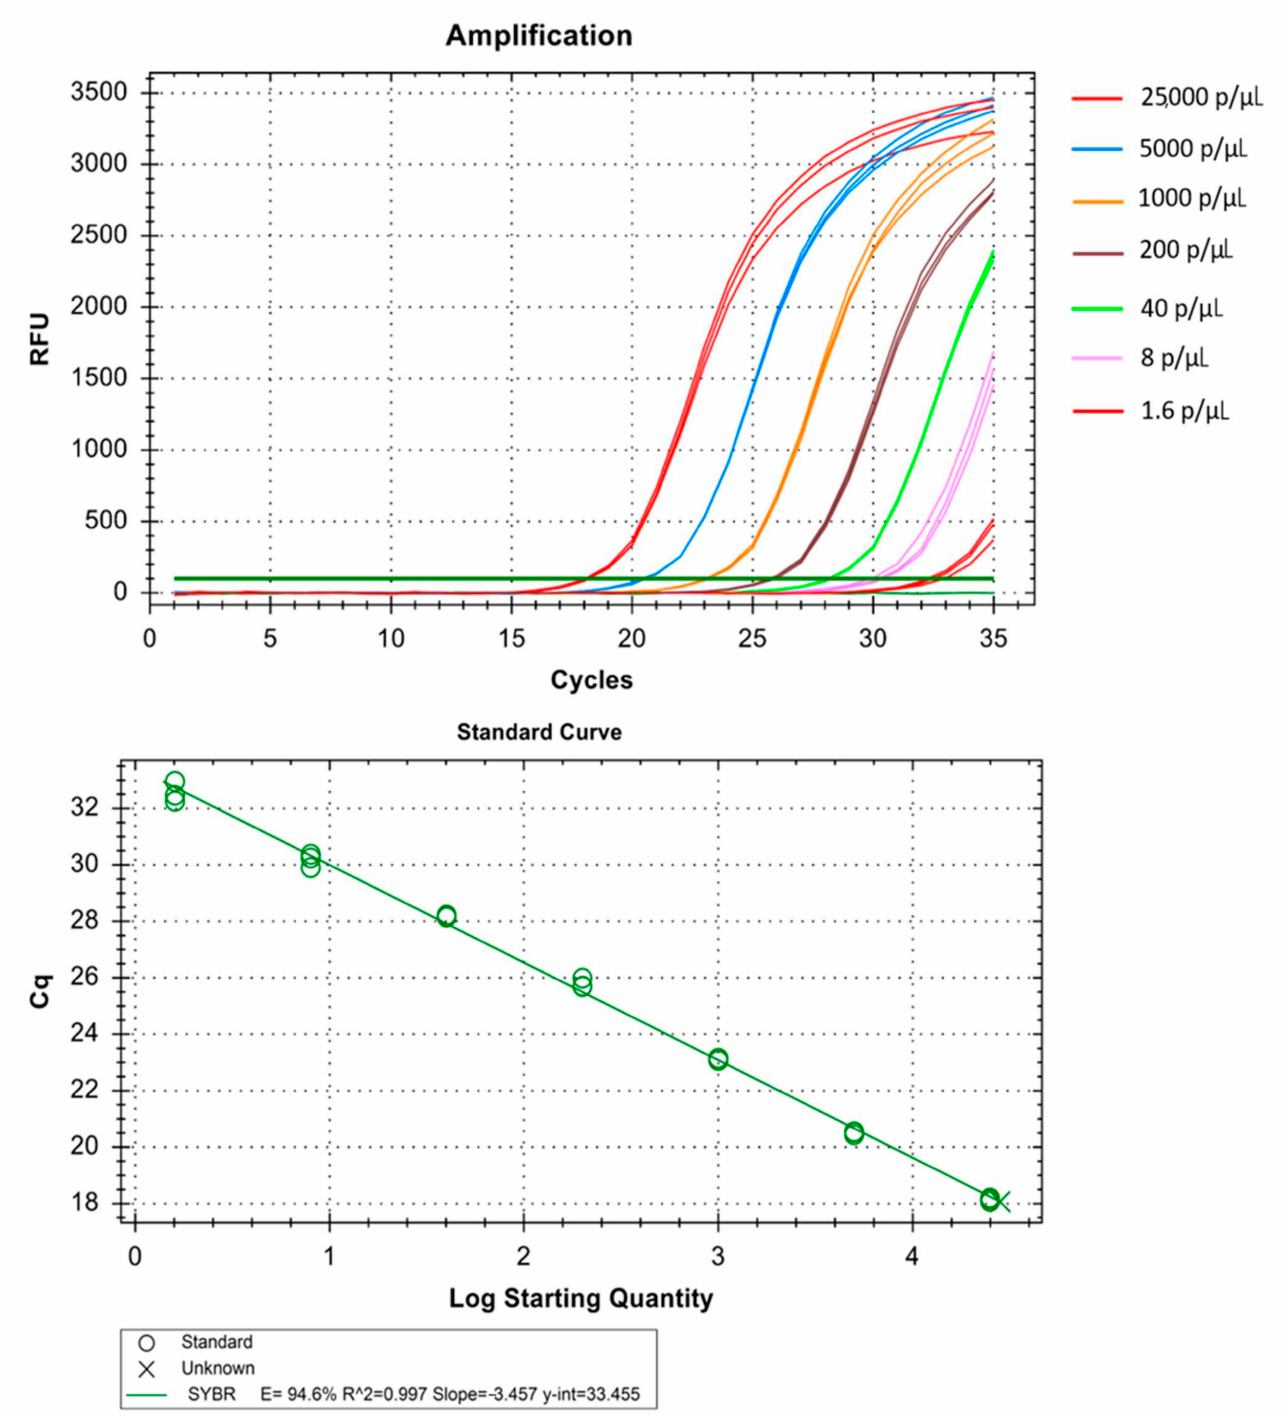
Figure 6. Technical performance and range of detection of the Pv real-time SYBR green PCR. Amplification curves of archived Pv samples with concentration ranging from 25 × 10 3 to 1.6 parasites/ µ L, have been depicted by different colors each containing a different parasite load. The standard curve has been made by the ct values obtained from the assay plotted against the logarithmic parasite concentration in a linear regression curve fit analysis (R 2 = 0.997, E =